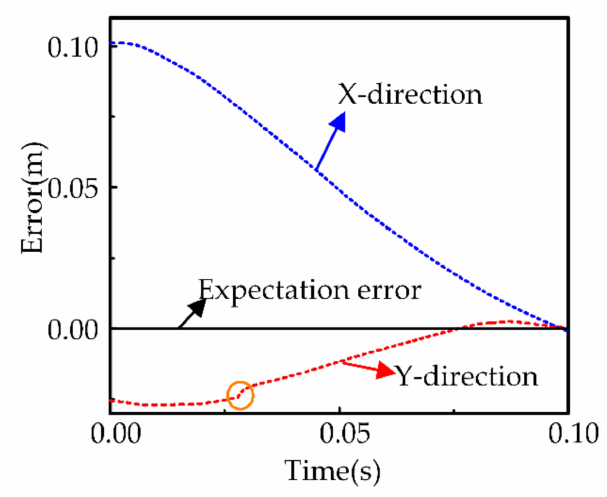
Figure 14. Robot position tracking error.